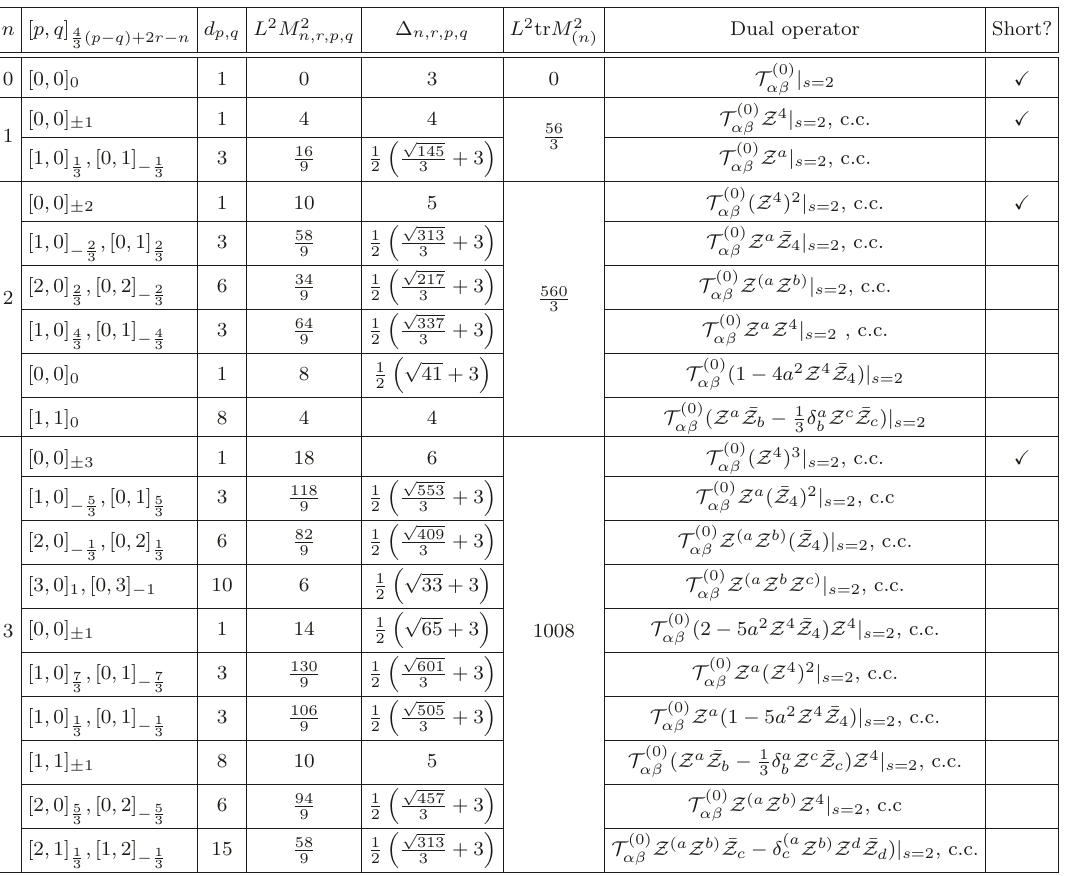
= 2 SU(3) U(1)-invariant solution [5] of N × U(1) ×